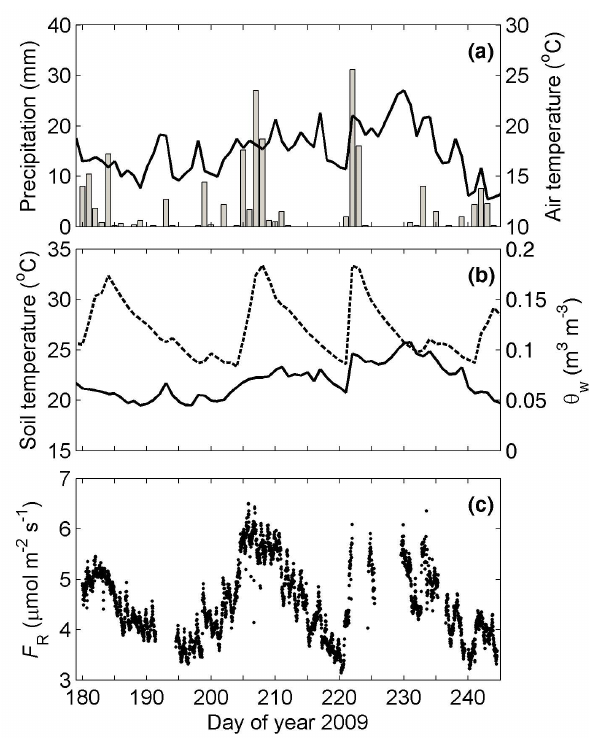
Fig. 4. (a) Daily total precipitation (bars) and mean air tempera- ture (solid line), (b) daily mean soil temperature (solid line) and mean soil volumetric water content ( θ w , dashed line) at 10cm depth, (c) half-hourly soil CO 2 flux ( F R ) . The gaps observed in F R data were caused by automatic soil chamber